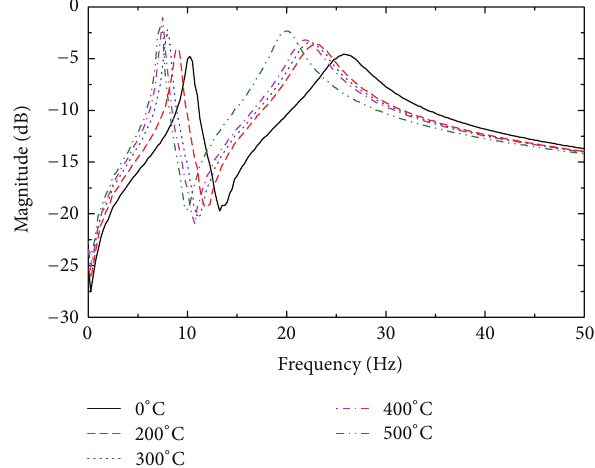
Figure 3: Amplitude-frequency responses of beam A and beam B driven by a hammer impact. Figure 4: Amplitude-frequency responses of beam B driven by a vibration shaker at different